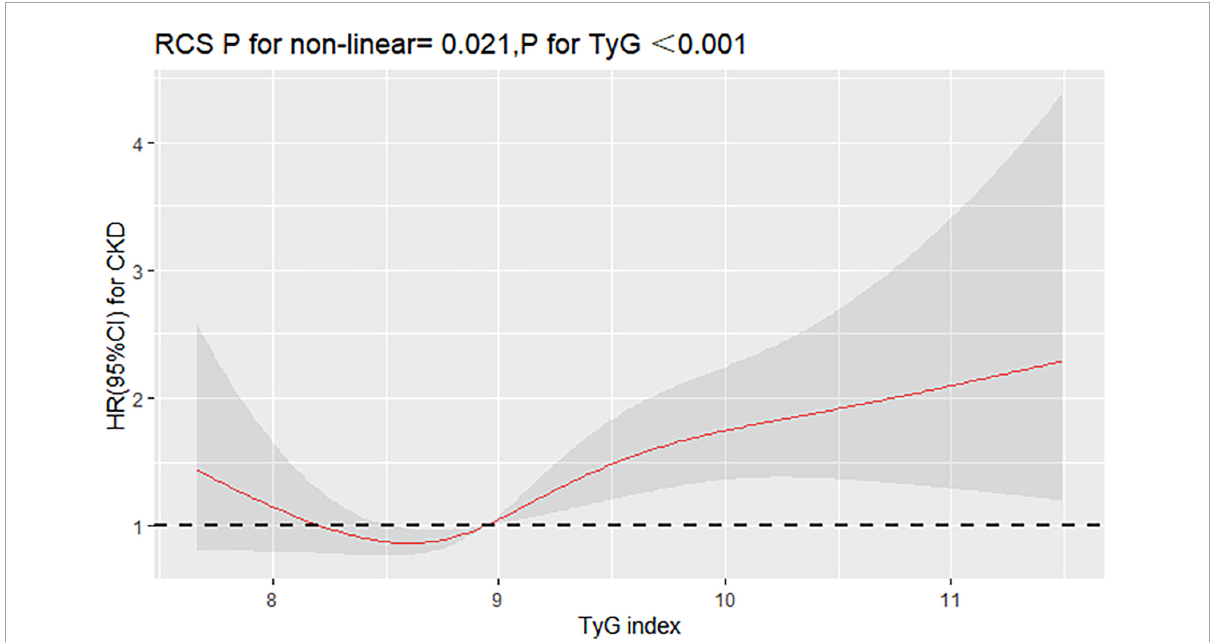
FIGURE3 Restricted cubic splines (RCS) for the shape of the association of TyG with CKD. It was used a multivariate Cox regression model of restricted cubic spline with 4 knots (at the 5th, 35th, 65th, and 95th percentiles) of TyG adjusting for potential covariates (including sex, age, smoke, drink, BMI, duration of hypertension, duration of diabetes, SBP, DBP, LDL-C, HDL-C, Cr, BUN, UA, lipid-lowering drugs, antidiabetic drugs, and antihypertensive drugs). The reference point for TyG index was 8.94 (the median of